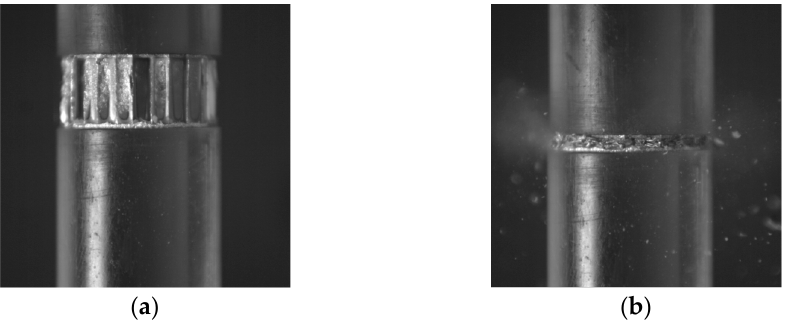
Figure 11. Deformation of sample 1/8-5052-0.0015 in the following time steps: ( a ) t = 0, and ( b ) t = 333.30 µs (based on results obtained in [21]). ( b ) t = 333.30 µ s (based on results obtained in